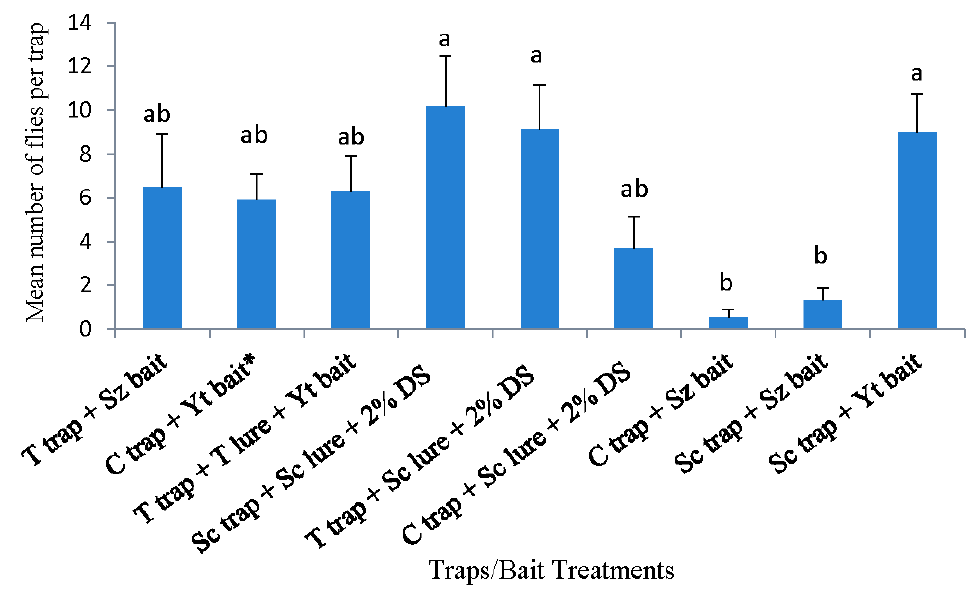
Figure 4. Drosophila suzukii flies captured in blueberry planting from 19 May 2016 to 23 June 2016 in Citra, Florida. Mean (± SE) number of adult flies within columns with different letters are significantly different ( p ≤ 0.05; Tukey’s HSD test) from each other. T trap = Trécé trap, T lure = Trécé lure, Sz bait = Suzukii trap, C trap = Cup trap, Yt bait = Yeast bait, Sc trap = Scentry trap, Sc = Scentry lure, and 2% DS = 2% detergent solution. * Reference treatment.